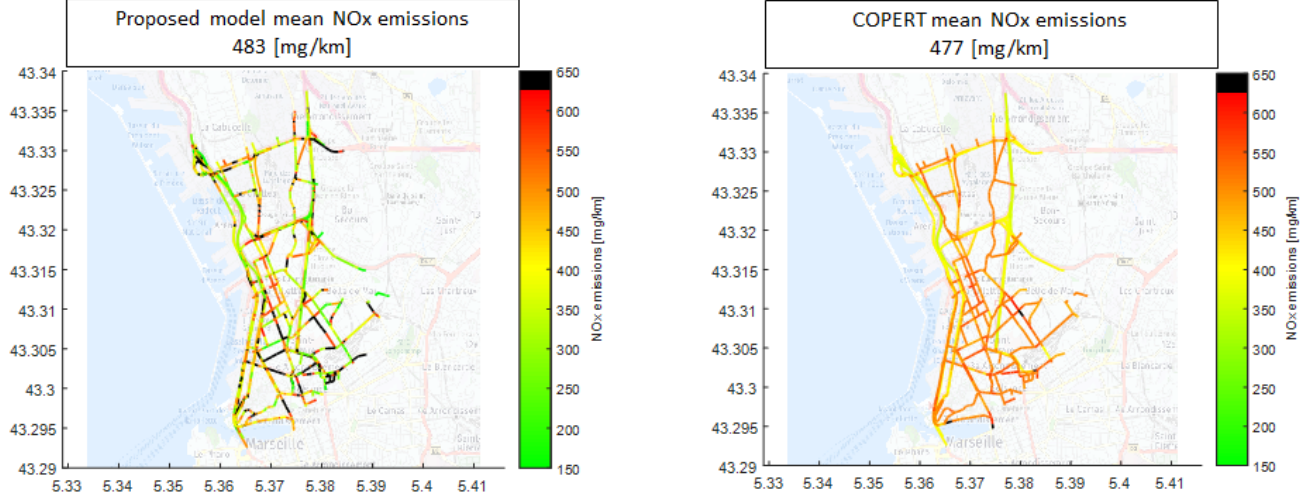
Figure 15. COPERT vs. proposed model. NO x emissions maps comparison in Marseilles, France. Colorbar color scale is black at 630 mg/km. Above this value, the road-link is considered a high emitter. The black color saturation is used to identify more easily critical road